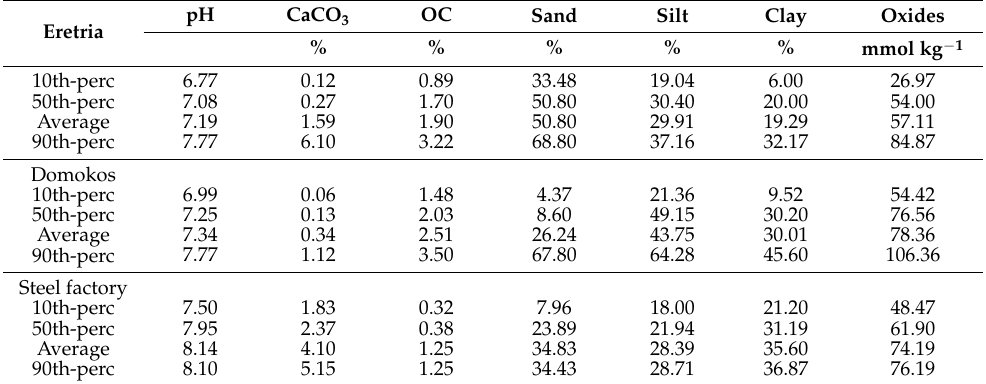
Table 1. Descriptive statistics of selected soil properties of the three study areas, Eretria, Domokos and the Volos steel